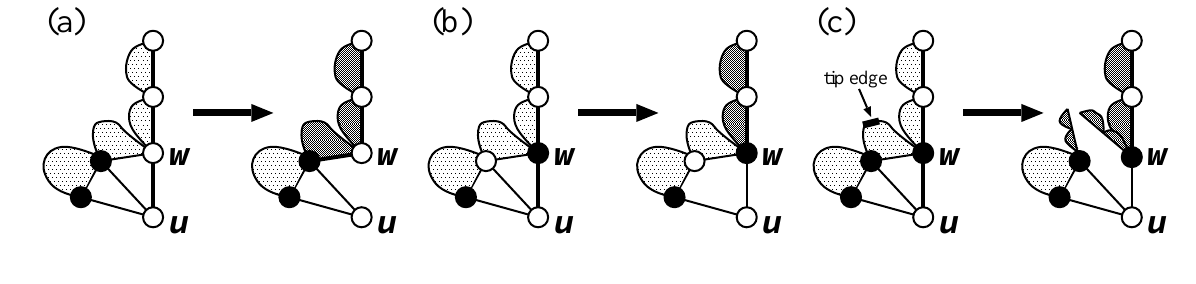
Figure 10. Three cases considered in the proof of Lemma 1. Bold lines and dark gray regions denote backbone edges and new blade bodies,